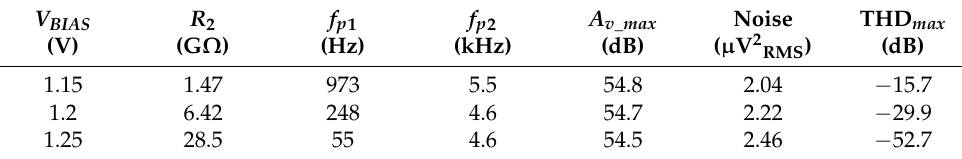
Table 1. Active band pass filter (BPF) simulated